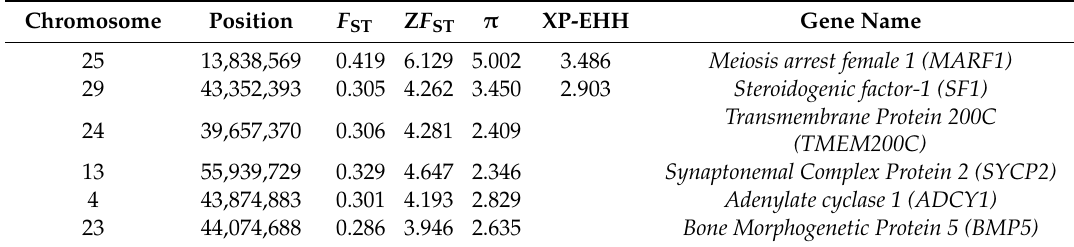
Figure 12. Venn diagram showing the overlapping genes in the top 1% of population differentiation index (F ST ), nucleotide diversity ( π ) and 0.1% of Cross-population extended haplotype homozygosity (XP-EHH). Table 5. Genomic loci containing the potential candidate genes.